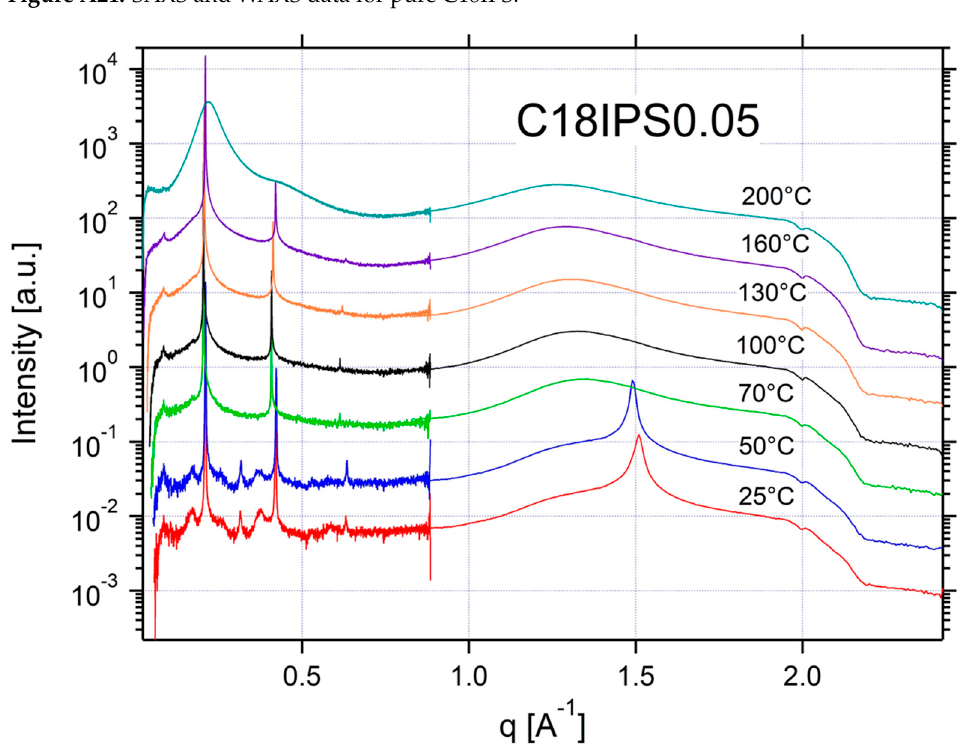
Figure A22. SAXS and WAXS data for 0.05:1 C18IPS:C18LiTFSI.